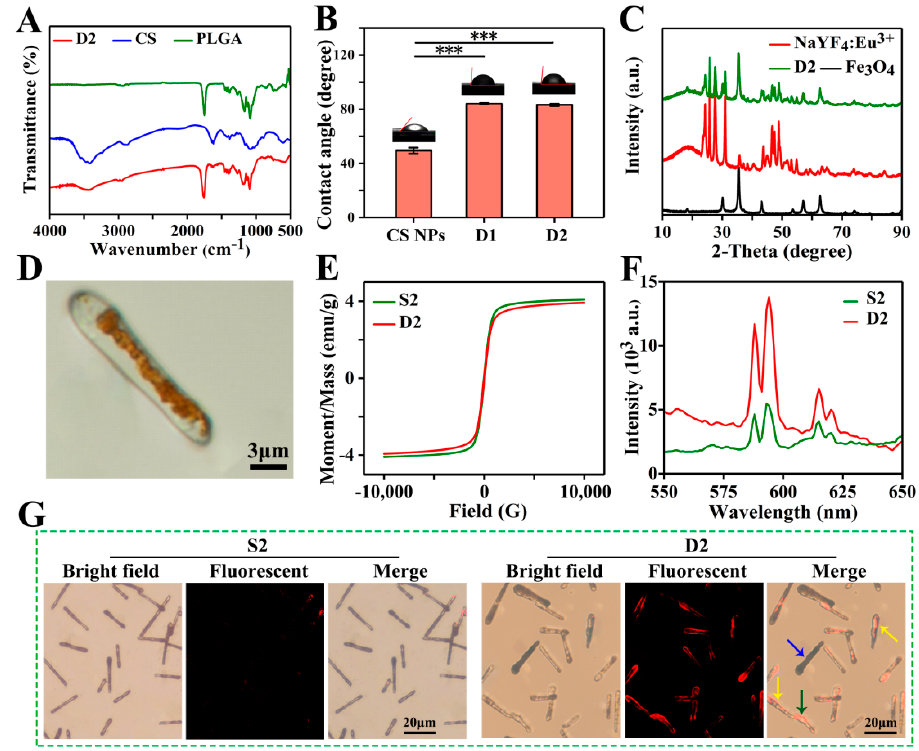
Figure 4. ( A ) FTIR spectra of CS, PLGA, and D2 DDCs. ( B ) Contact angles of CS NPs and D1 and D2 DDCs, and the corresponding images of water droplets on different samples, *** p < 0.001. ( C ) XRD patterns of Fe 3 O 4 MNPs, NaYF 4 :Eu 3+ NPs, and D2 DDCs. ( D ) Optical microscope image of D2 DDC. ( E ) Hysteresis loops of S2 and D2 DDCs. ( F ) Emission spectra of S2 and D2 DDCs. ( G ) Fluorescent microscope images of S2 and D2 DDCs.